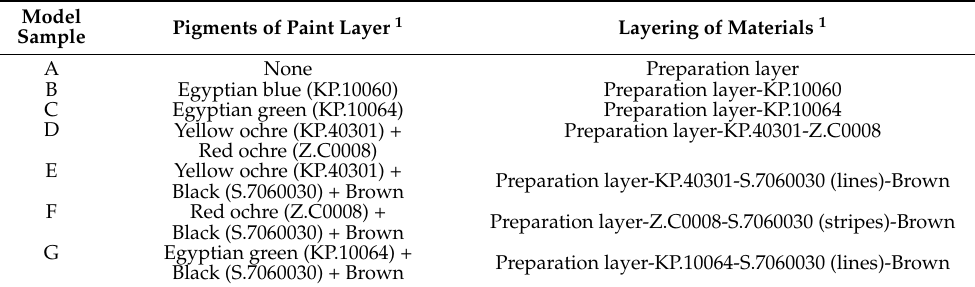
Figure 4. Mockups (series 5) used for cleaning trials, before ( a ) and after the soiling procedure ( b ). In the soiled samples, the reference area is covered with a white paper tissue. Table 1. Mockups’ composition. Preparation layer is calcium carbonate with gum Arabic as binder (10% solution in water), Brown is a mixture of 50% Burnt umber (Z.C0798), 25% Red ochre (Z.C0008) and 25% Green earth (Z.C0320).